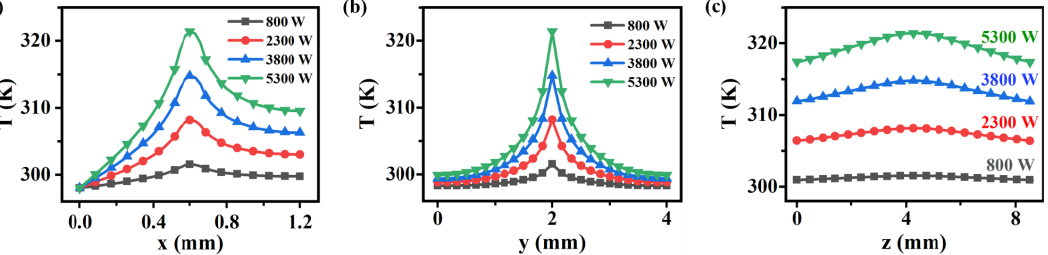
Figure 3. Temperature distribution of ( a ) x-axis intercept in crystal center plane, ( b ) y-axis intercept in crystal center plane, and ( c ) crystal axis at different pumping power levels.